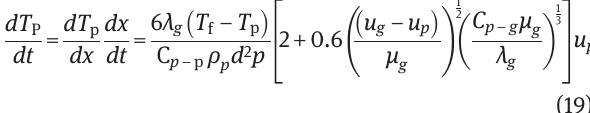
Figure 1. The structure of spray gun consists of five parts: